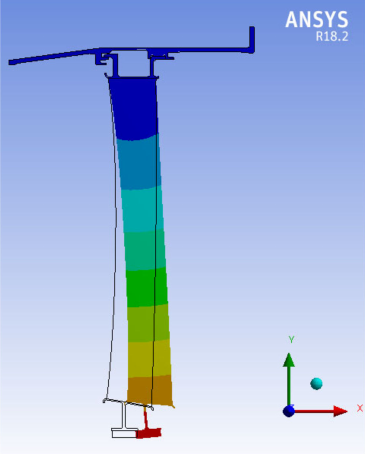
Figure 7. First system mode of the nozzle-casing